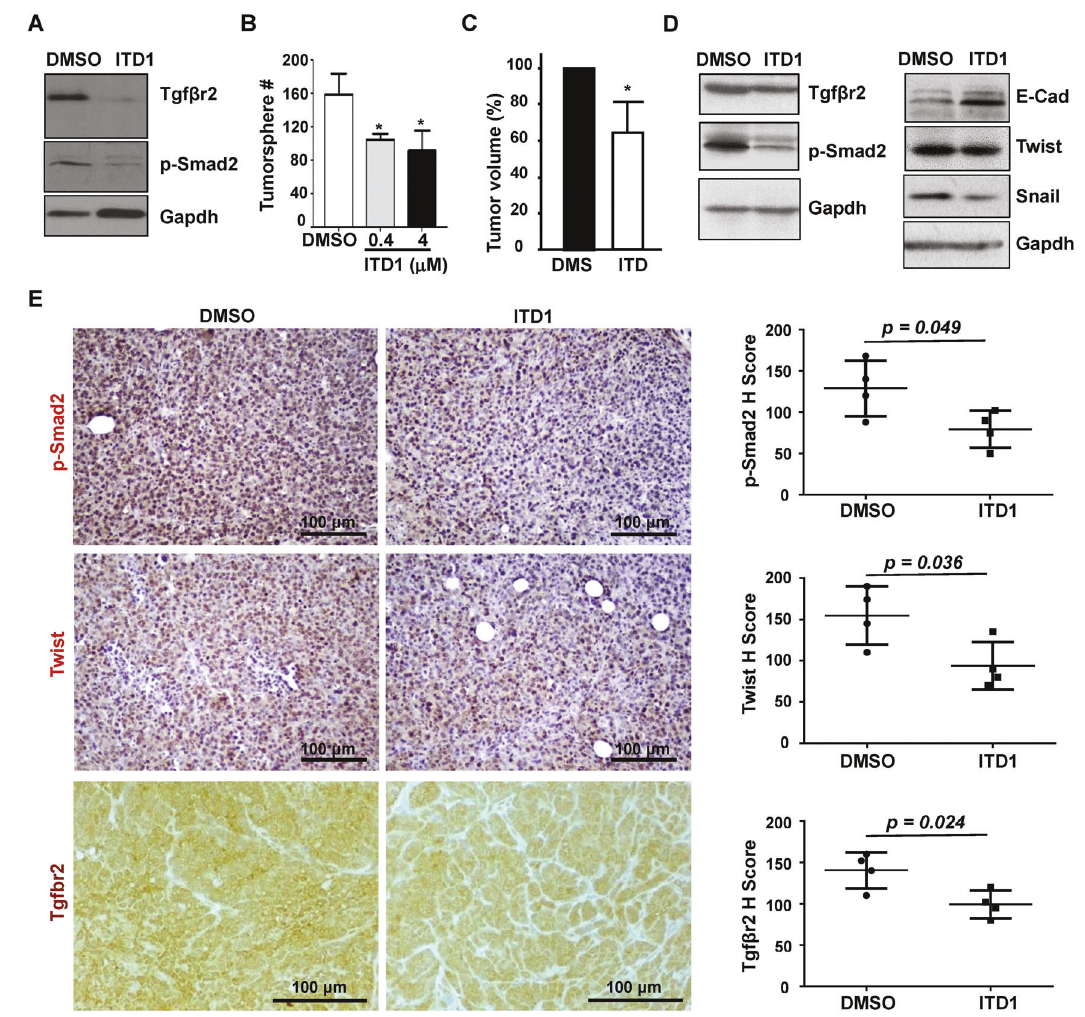
Fig. 6 Pharmaceutical inhibition of Tgf β r2 in Brca1 de fi cient tumor cells suppresses EMT, tumorsphere formation, and tumor initiation. A 18 − / − ; Brca1 MGKO tumor cells treated with ITD1 at 4 μ m for 24 h were analyzed by western blot. B 10 4 cells dissociated from 18 − / − ; Brca1 MGKO primary tumorspheres were treated with ITD1. Secondary spheres formed after 6 days of treatment were counted from quadruplicate experiments. Data represent the mean ± SD from two independent primary tumorspheres. C 1000 p18 − / − ; Brca1 MGKO tumorsphere-dissociated cells pretreated with DMSO or ITD1 for 6 days were transplanted into MFPs of NSG mice. Four weeks later, mice were dissected and tumor volumes were measured. Values represent the average tumor volumes ± SD of four tumors. The asterisk (*) in ( B ) and ( C ) denotes a statistical signi fi cance from ITD1 treated and DMSO treated samples determined by a two-tailed, unpaired T test. D , E Representative tumors generated by DMSO- or ITD1-pretreated p18 − / − ; Brca1 MGKO cells were analyzed by Western blot ( D ) and IHC ( E ). The H-scores for p-Smad2, Twist, and Tgf β r2 in IHC were calculated (E, right panel). The results represent the mean ± SD of four individual tumors per group. Statistical signi fi cance was determined by a two-tailed, unpaired T